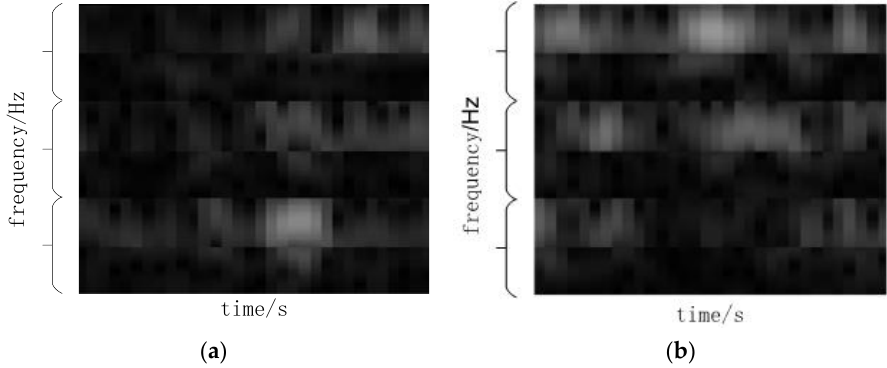
Figure 12. Time-frequency pattern of two-classification dataset, ( a ) imagining a time-frequency pattern of left-handed motion, ( b ) imagining a time-frequency pattern of right-handed motion. For the four-classification datasets 2a and 3a, the EEG bands related to the collected EEG signal and motion imaging are mainly concentratedin 8Hz to 30Hz. Thus, after seg- menting the original data, the EEGLAB toolbox built into Matlab’s FIR filter is used for